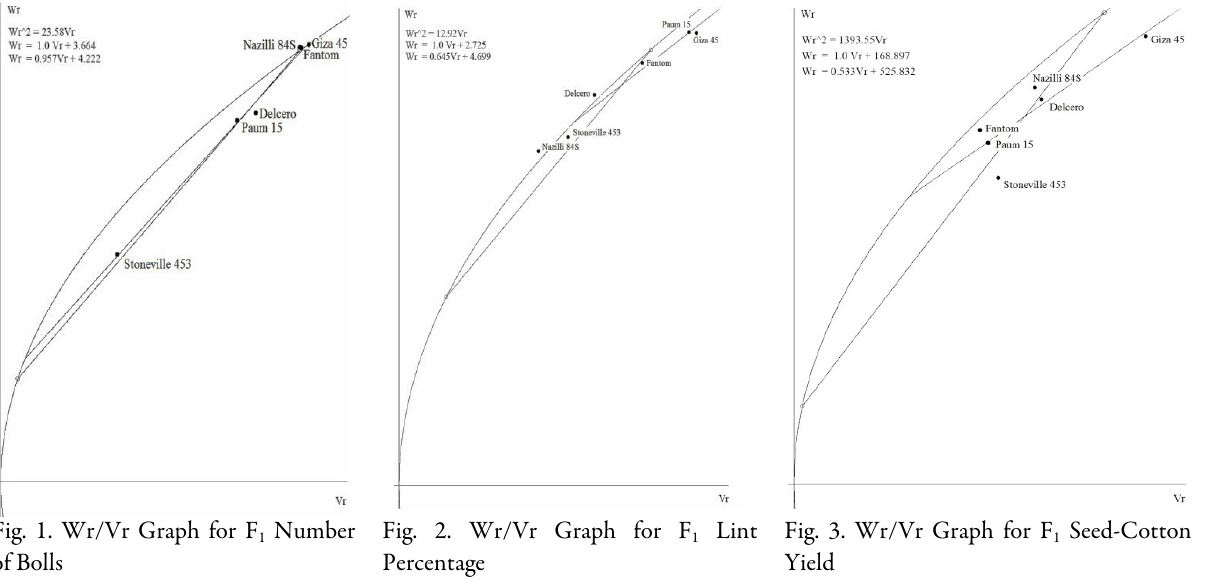
Fig. 1. Wr/Vr Graph for F of Bolls